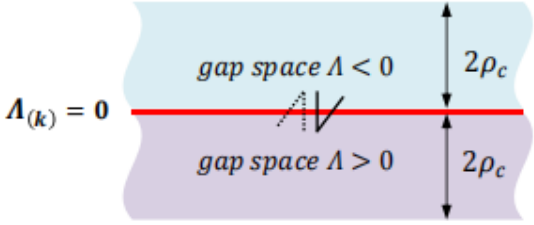
Figure 3. Description of gap space vector 𝛬 for the contact